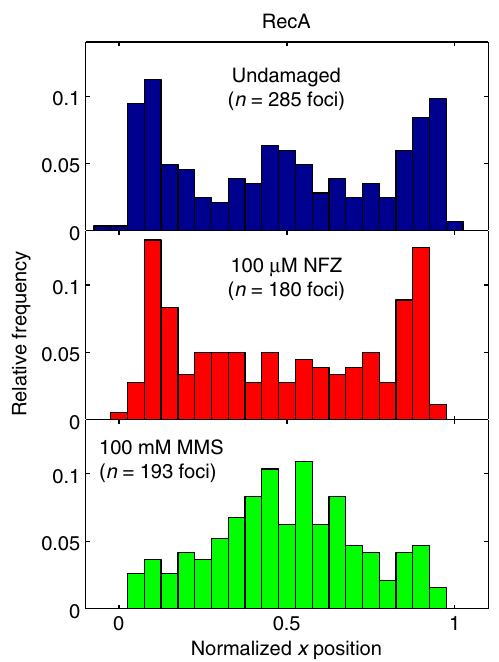
Fig. 6 Effect of NFZ and MMS treatment on RecA cellular localization. Long-axis cellular localization of RecA-GFP foci in undamaged cells (top) and cells treated with 100 µ M NFZ (middle) or 100 mM MMS